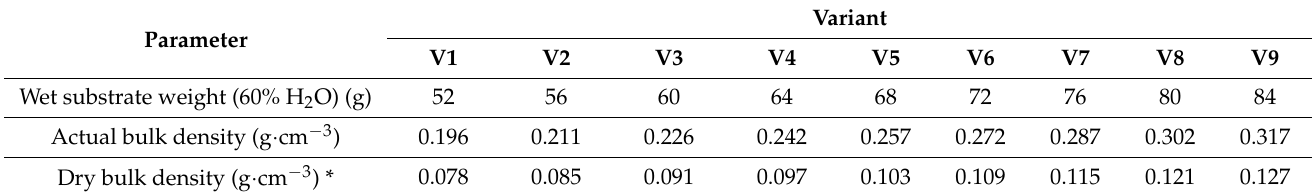
Table 1. Mass of the substrate, with a humidity of 60%, used to fill the cells of the various variants, and the corresponding actual and dry bulk